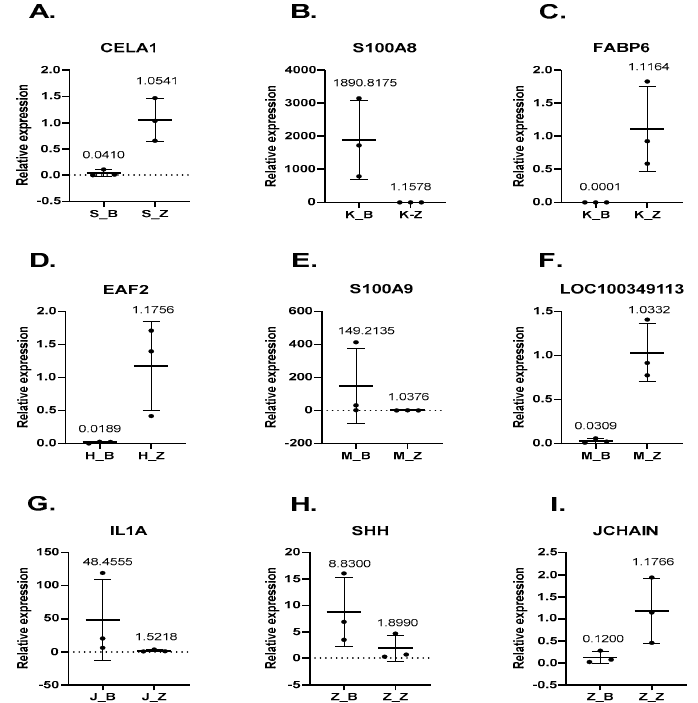
Figure 7. Expression level of genes CELA1, S100A8, FABP6, EAF2, S100A9, LOC100349113, IL1A, CYP4B1, SHH, and JCHAIN validated by RT-qPCR. The β -actin gene was used as an internal control and the relative quantity of gene expression (fold change) of each gene was calculated with the comparative 2 − ∆∆ CT method. Values (RT-qPCR) shown are mean with SD.